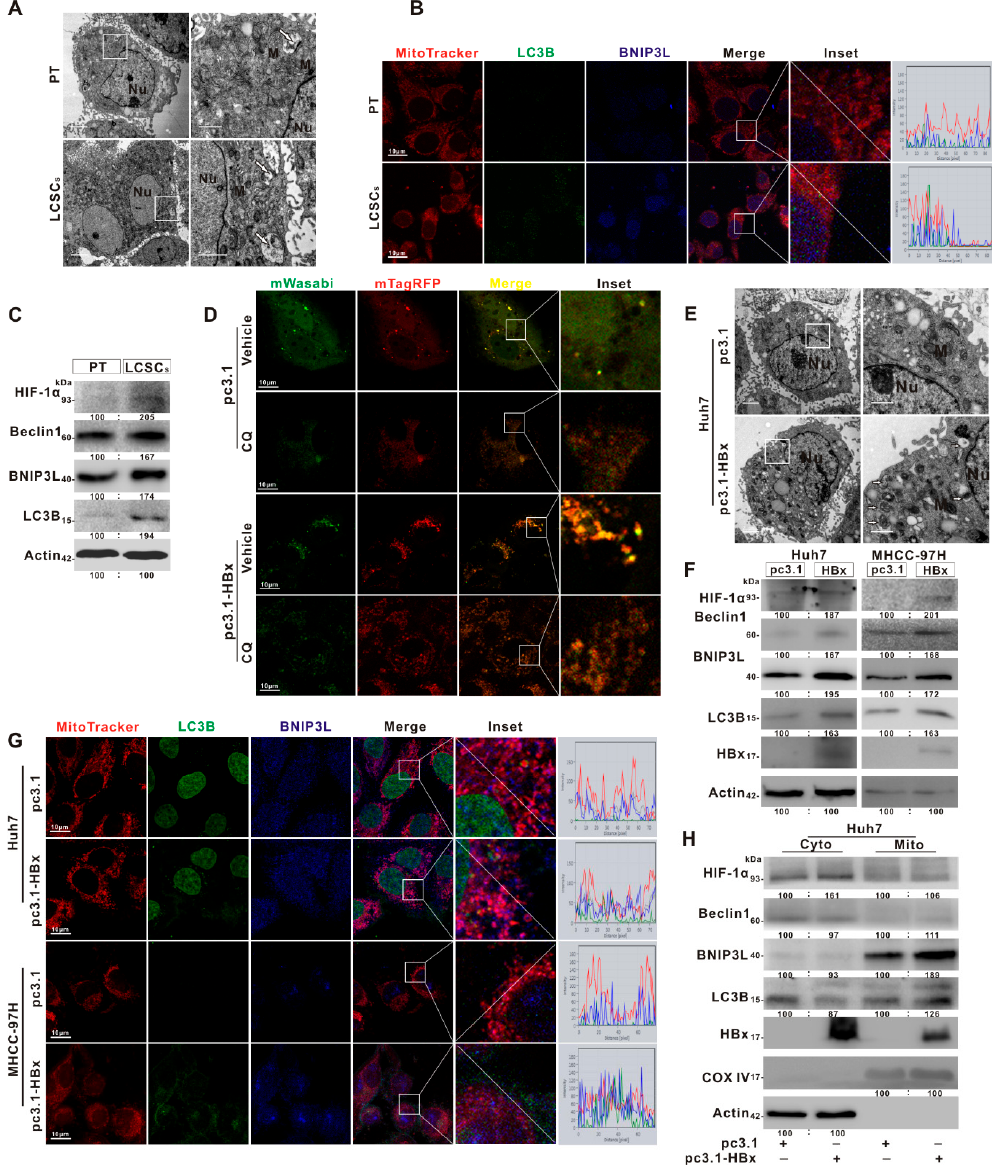
Figure 5. BNIP3L-dependent mitophagy was induced in HBx-expressing HCC cells and LCSCs. ( A – C ) LCSCs were enriched in Huh7 cells by sphere-formation assay, and normally cultured Huh7 cells